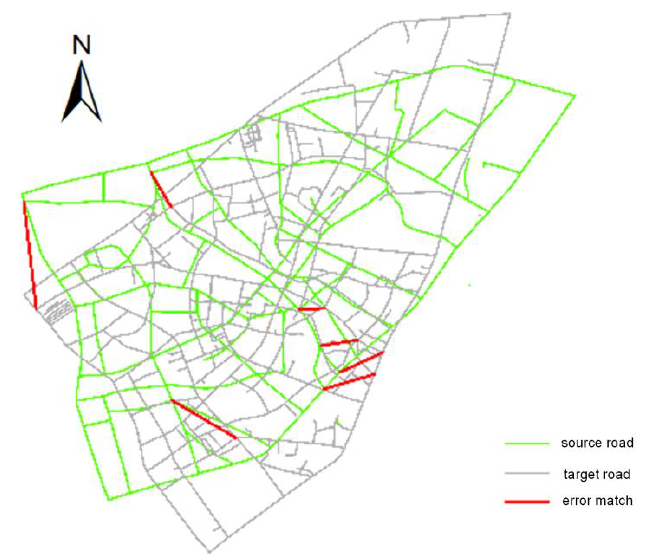
Figure 26. Mismatches by using DTRM with a rotation angle of 30°.